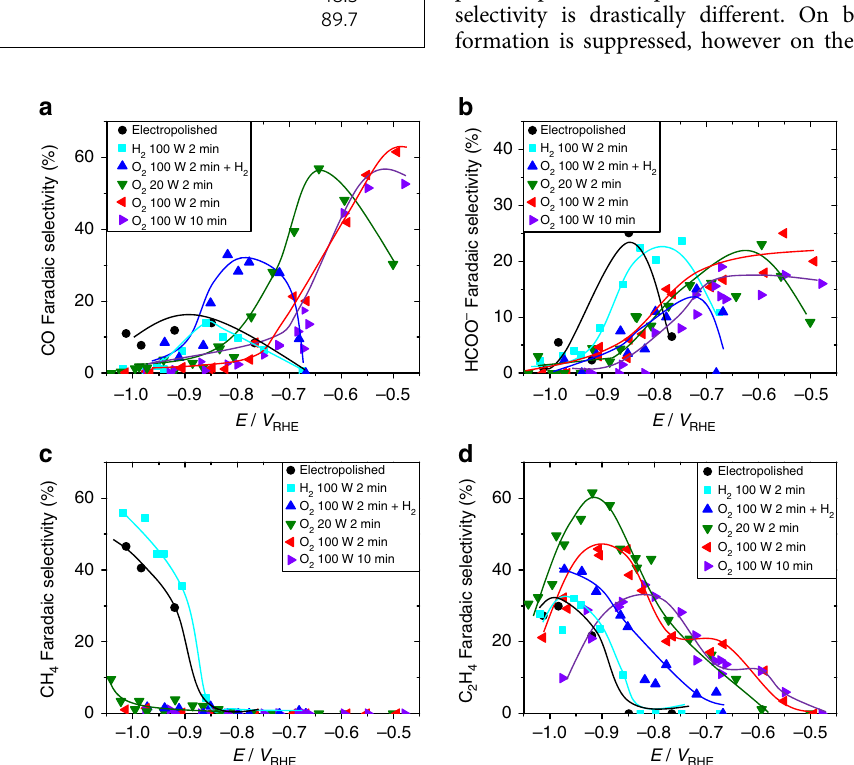
Figure 5 | Faradaic selectivities of the main CO 2 RR products. Data were acquired after 60min of CO 2 electrolysis at a constant potential in CO 2 saturated 0.1M KHCO 3 . ( a ) CO, ( b ) formate, ( c ) CH 4 ( d ) C 2 H 4 . Solid lines are guides for the eye. The remaining selectivity is due to H 2 , which is shown in Supplementary Fig. 8.